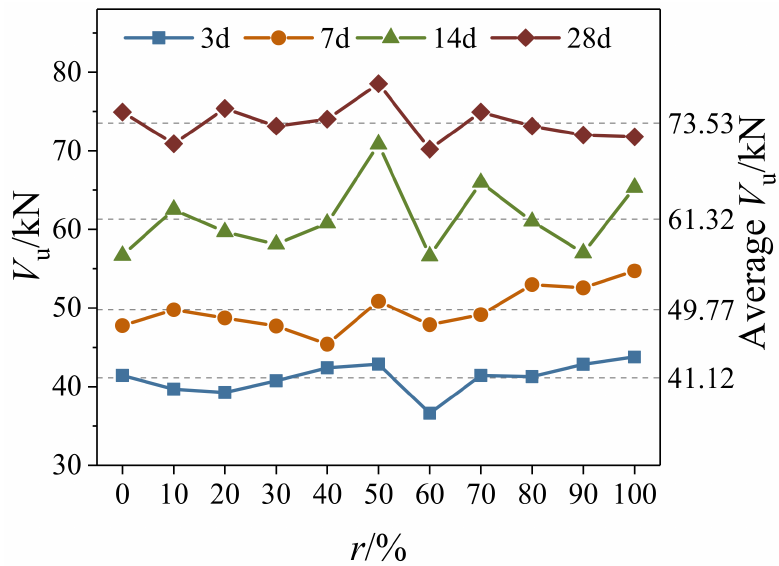
Figure 8. Peak shear force of RAC with different replacement